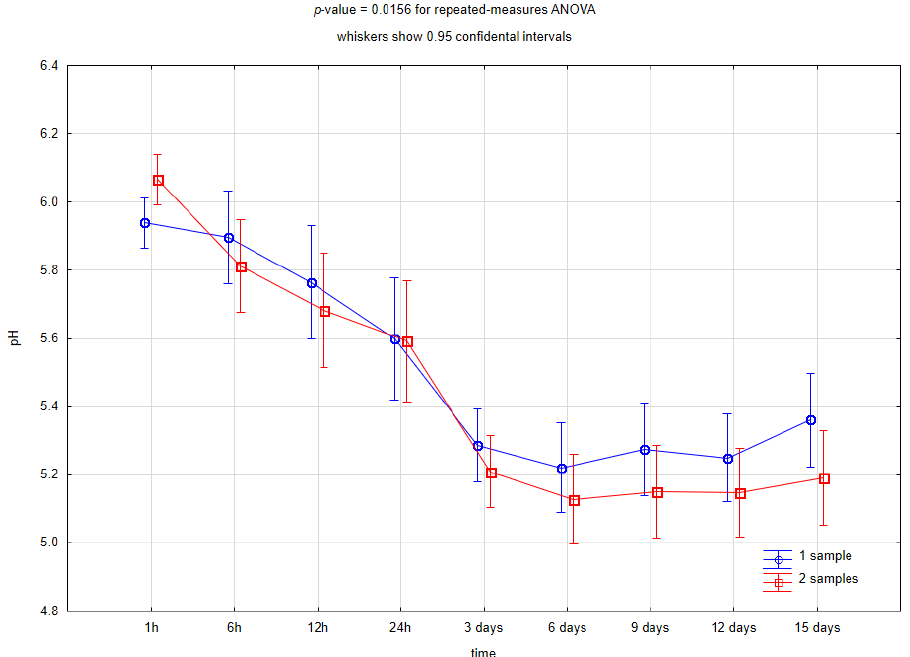
Figure 7. Repeated-measures analysis of variance for pH values in the individual time points depending on the number of the samples for Filtek Bulk Fill.